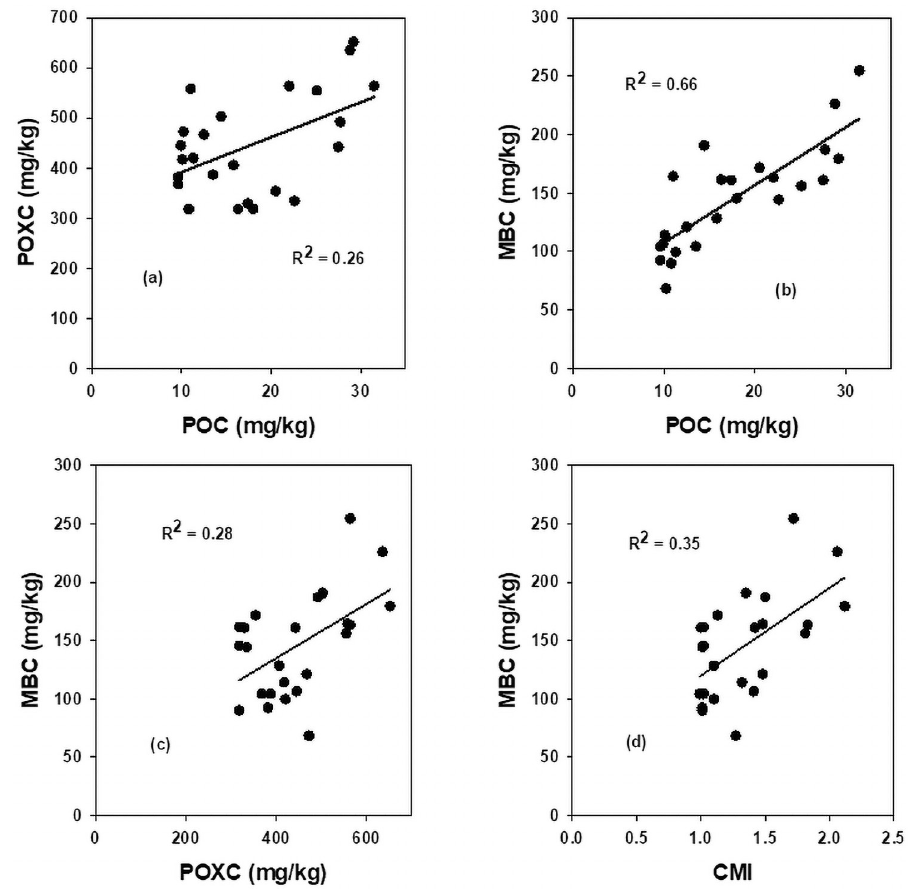
(d) microbial biomass carbon with carbon management index, averaged across